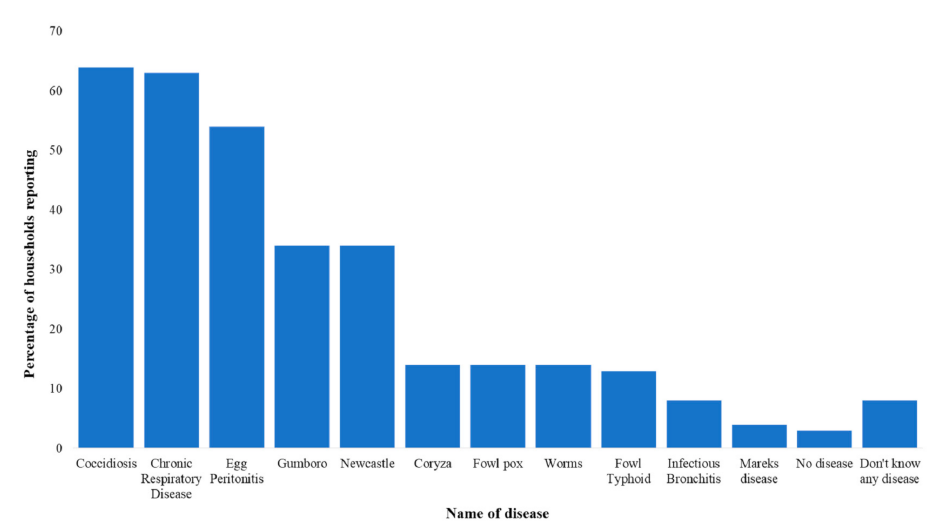
Figure 2. Common diseases or health conditions reported for layers in Gatundu North,